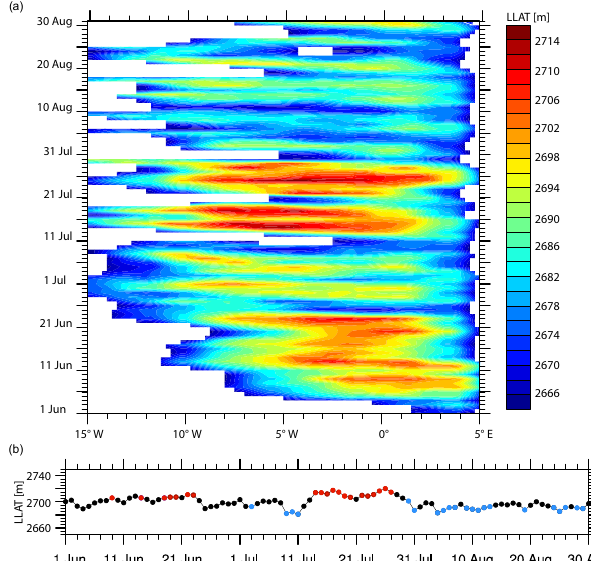
Figure 9. (a) Hovmöller diagram of low-level atmosphere thickness (LLAT) (m) representing the SHL at 23 ◦ N. (b) Time series of maxi- mum LLAT (m) for June to August 2013. Blue circles indicate daily LLAT maximum values less than the 25th percentile, red circles in- dicate daily LLAT maximum values above the 75th percentile. The LLAT is calculated from COSMO-MUSCAT simulation following Lavaysse et al.